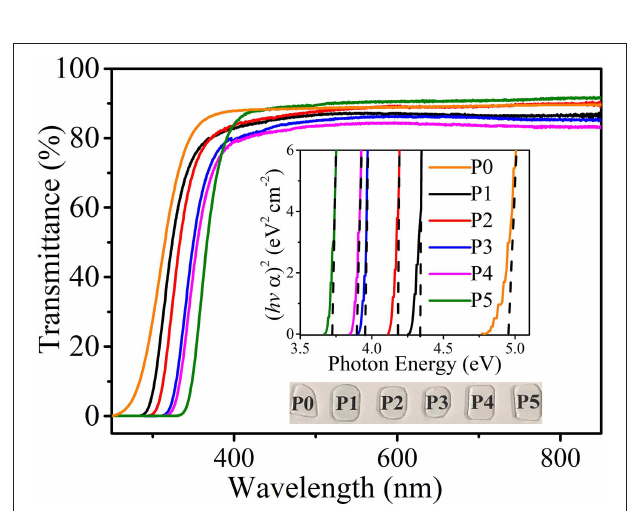
FIGURE 1 | Transmission spectra of samples P0–P5. Insets present the relationship of ( hv α ) 2 vs. photo energy and the photographs of samples P0–P5, respectively.